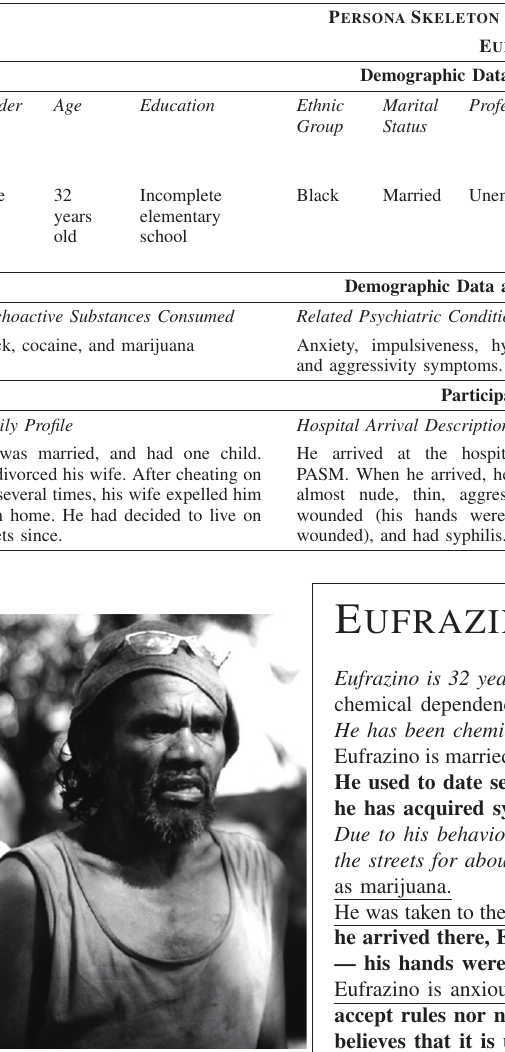
TABLE I E UFRAZINO (F IG . 7), A P ERSONA WITH CHEMICAL DEPENDENCY . T HE INFORMATION TO CREATE HIS SKELETON CONTAINS DATA FOR DIFFERENT SOURCES ( PARTICIPATORY ACTIVITIES , AND DEMOGRAPHIC DATA ).